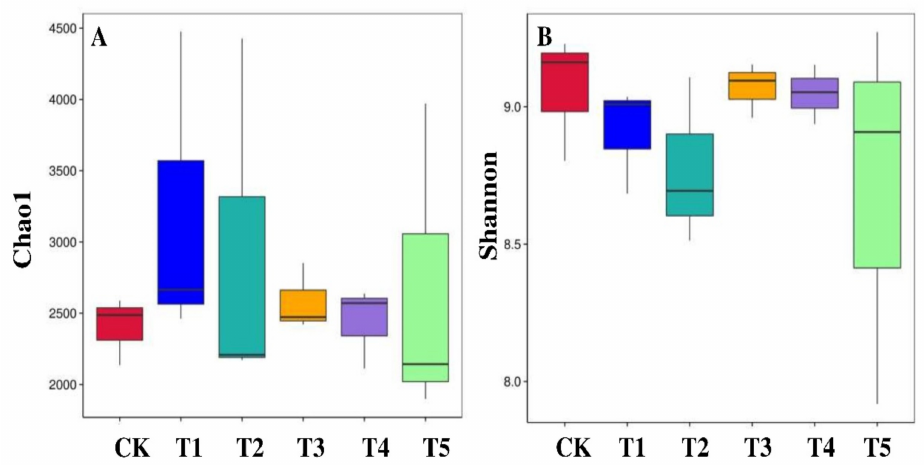
Figure 4. Bacterial alpha diversity measurements represented by ( A ) Chao1 index as richness and ( B ) Shannon index as diversity in each treatment, derived from the QIIME (http://qiime.org/, accessed on 30 May 2022) command α